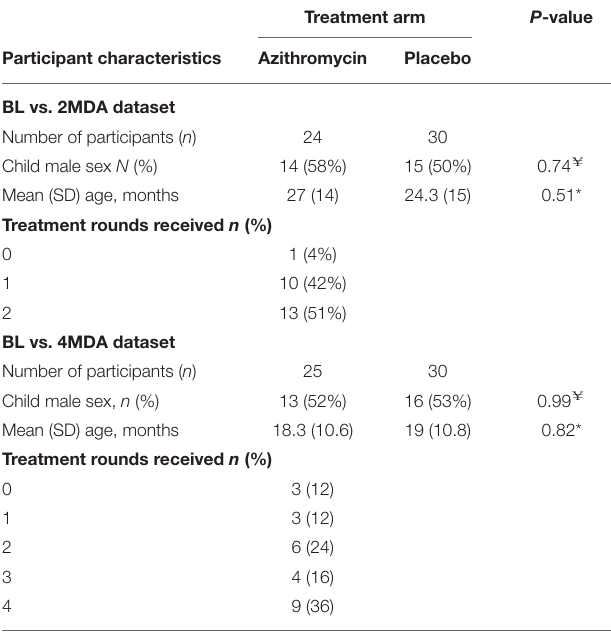
TABLE 2 | Comparison of baseline participant characteristics between treatment groups for the BL vs. 2MDA and BL vs. 4MDA datasets. Treatment arm P